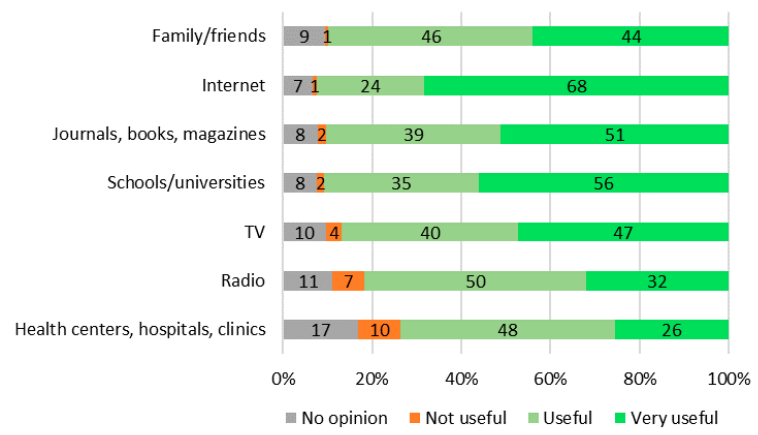
Figure 4. Opinion about the media that could be used to disseminate information about